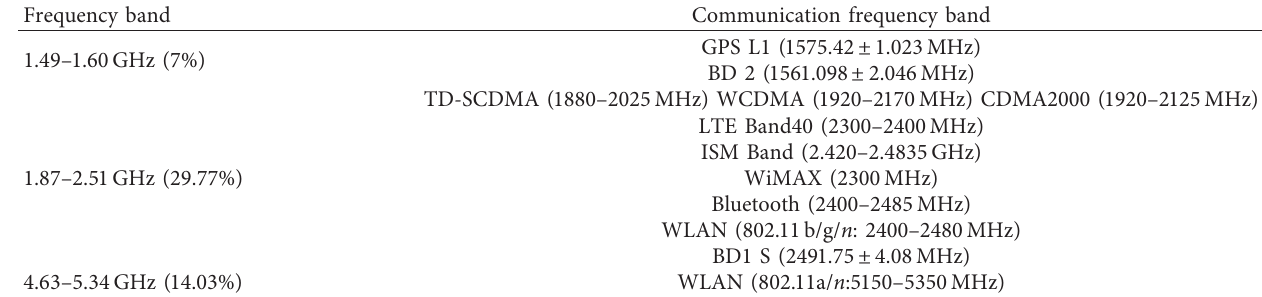
Table 3: Antenna’s commercial communication frequency